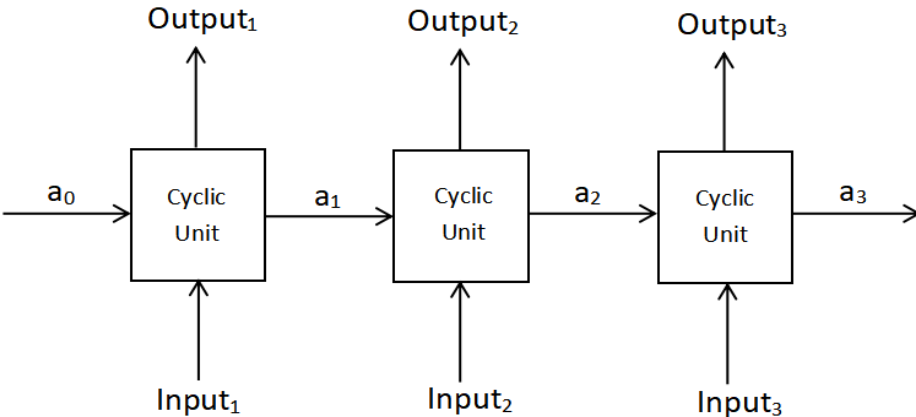
Figure 3. This is a recurrent neural network model, where a is the parameter passed between the cyclic units.